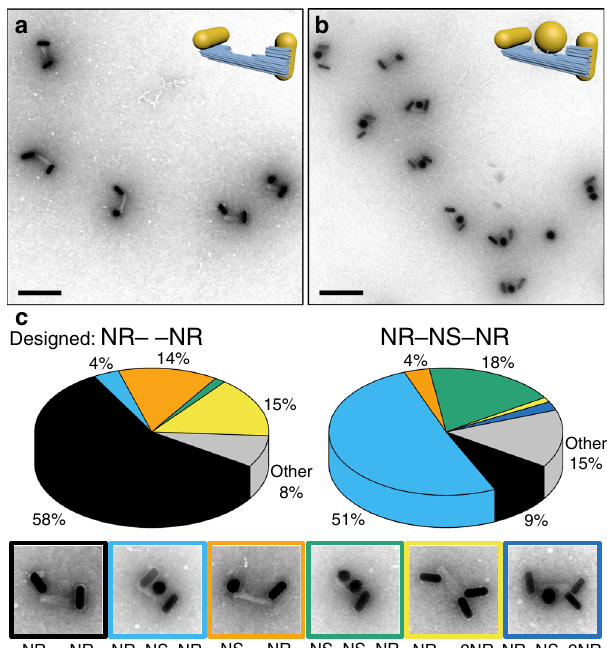
Fig. 2 Assembly yields. a Electron micrograph of sample NR – – NR, and b of sample NR – NS – NR. Scale bar: 200 nm. c Distribution of assemblies in the samples NR – – NR and NR – NS – NR. Structures assembled as designed pose the majority with a variety of misassemblies occurring. The colored sections of the pie diagram correspond to the various con fi gurations displayed in the TEM images with colored frames. Approximately 500 individual assemblies were studied (cf. Supplementary Note S3).